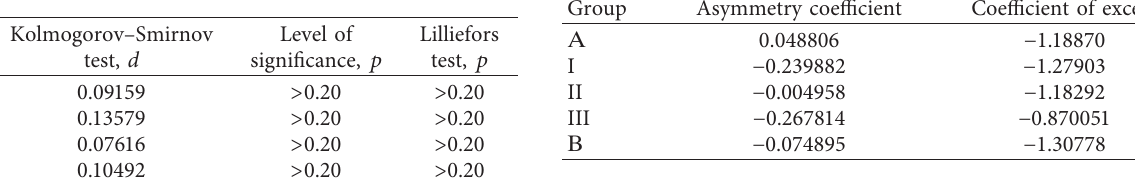
Figure 8: The distribution histogram of the stress experimental values with the overlaid curve of the expected normal distribution (a) and the graph of the normal distribution (b) for the deposited samples of group B. Table 11: The results of checking the sample for normality by Table 12: The values of the asymmetry and excess Kolmogorov–Smirnov and Lilliefors tests.